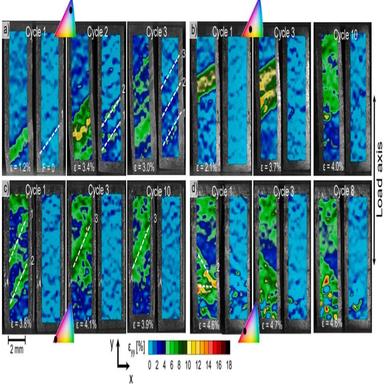
Local strain fields plotted with respect to the load axis (vertical) εyy at the state of maximum deformation (left) and after complete unloading (F = 0 N; right) of the four compression specimens with different crystallographic orientations for different number of cycles. (a) 〈111〉 oriented crystal, (b) 〈113〉 oriented crystal, (c) 〈001〉 oriented crystal, (d) 〈013〉 oriented crystal. Regions of martensitic deformation bands are indicated by white dotted lines and are labelled according to their appearance.